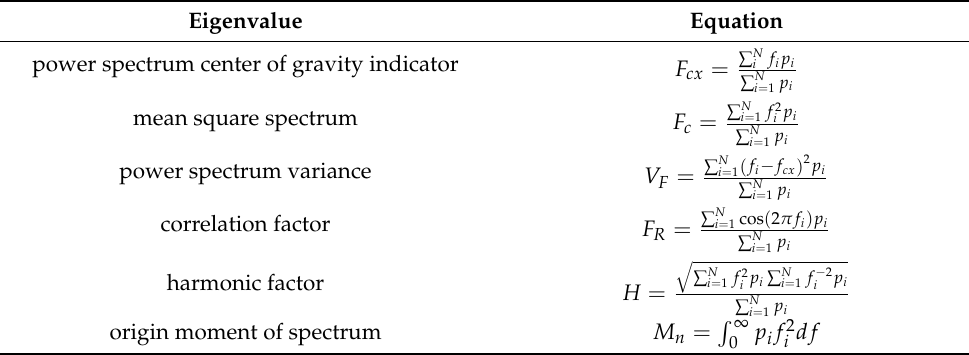
Table 3. Frequency domain eigenvalue.